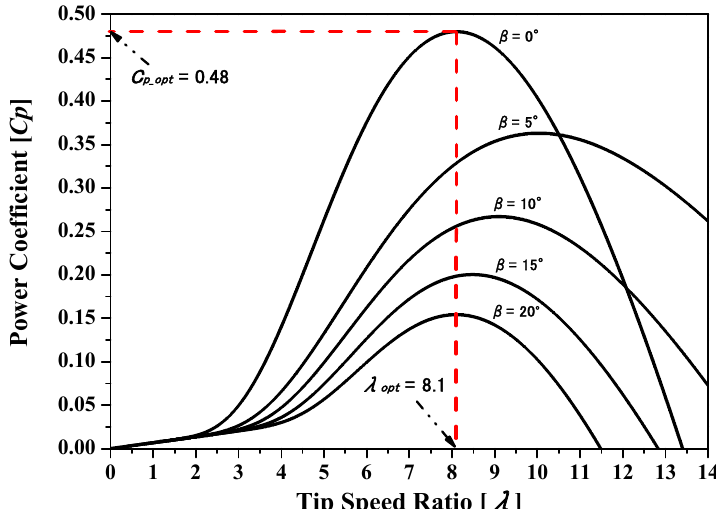
Figure 2. C p vs. λ characteristics with various β . Figure 2. (cid:1829) (cid:3043) vs.(cid:2019) characteristics with various (cid:2010) . Figure 2. (cid:1829) (cid:3043) vs.(cid:2019) characteristics with various (cid:2010) . Figure 2. (cid:1829) (cid:3043) vs.(cid:2019) characteristics with various (cid:2010) .